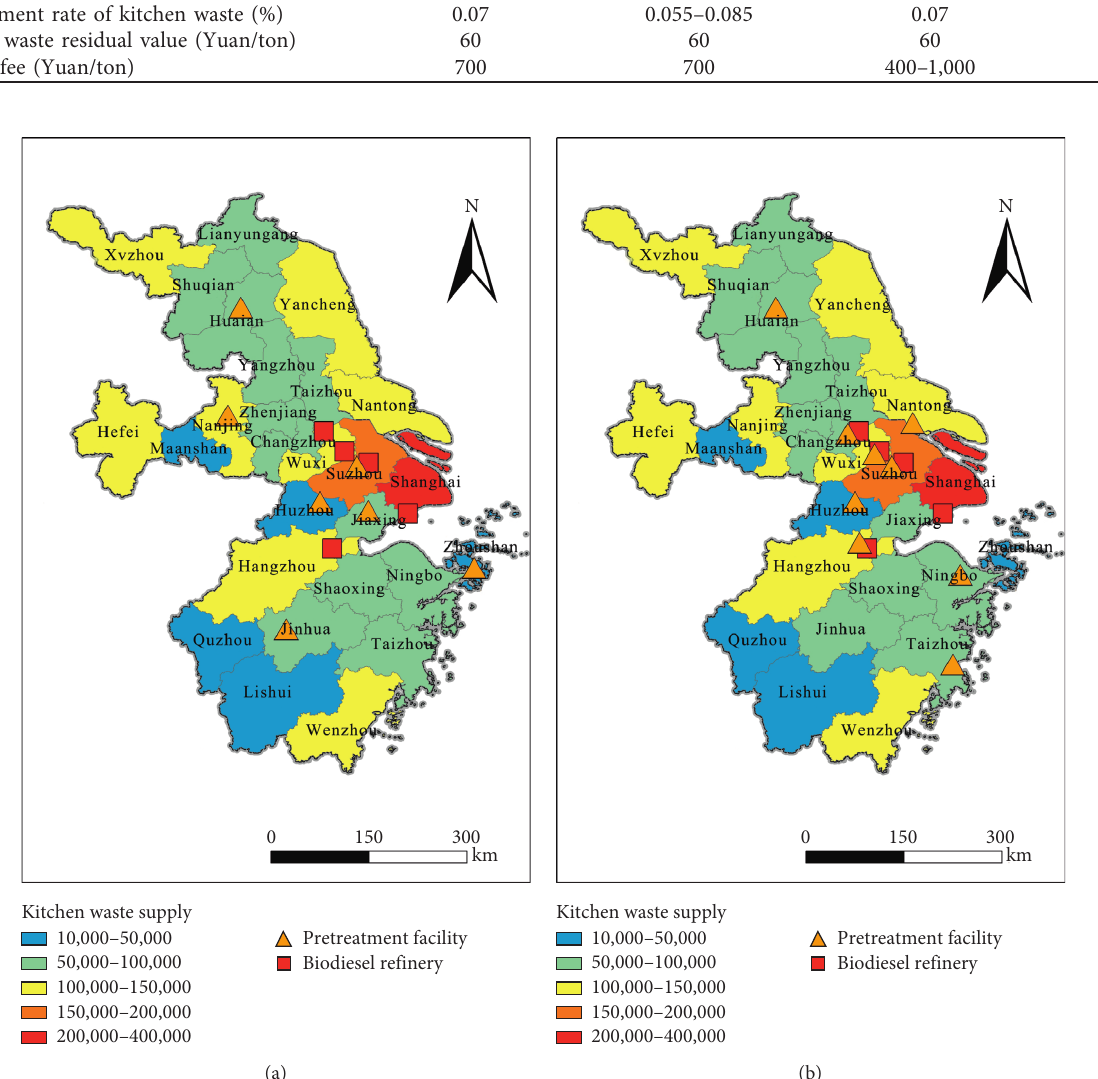
Figure 6: Network structure sensitivity analysis of penalty fee. (a) Penalty fee of 400 Yuan/ton. (b) Penalty fee of 1000